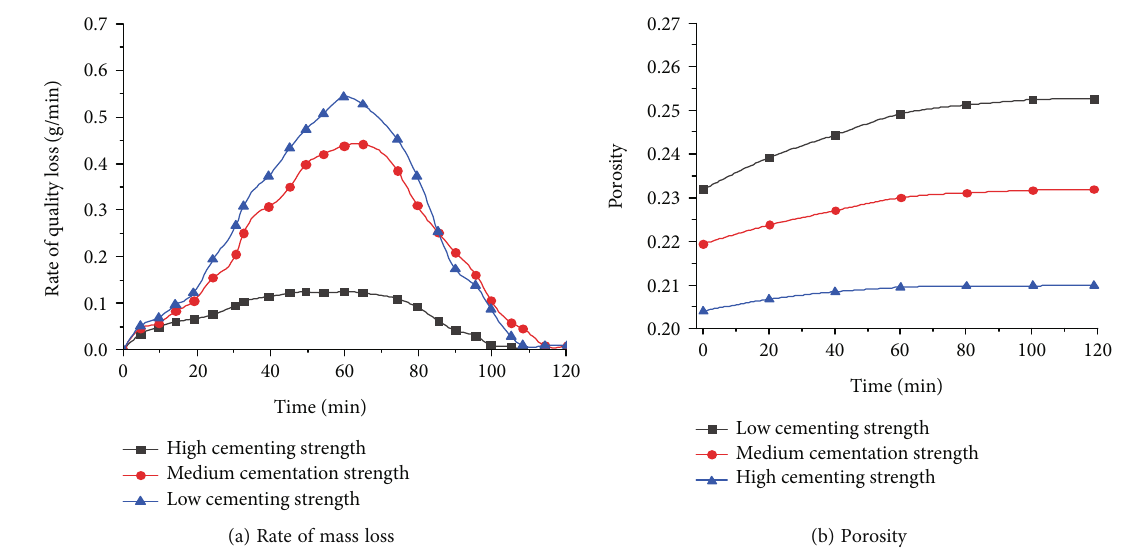
Figure 7: Seepage evolution in various cemented strengths.